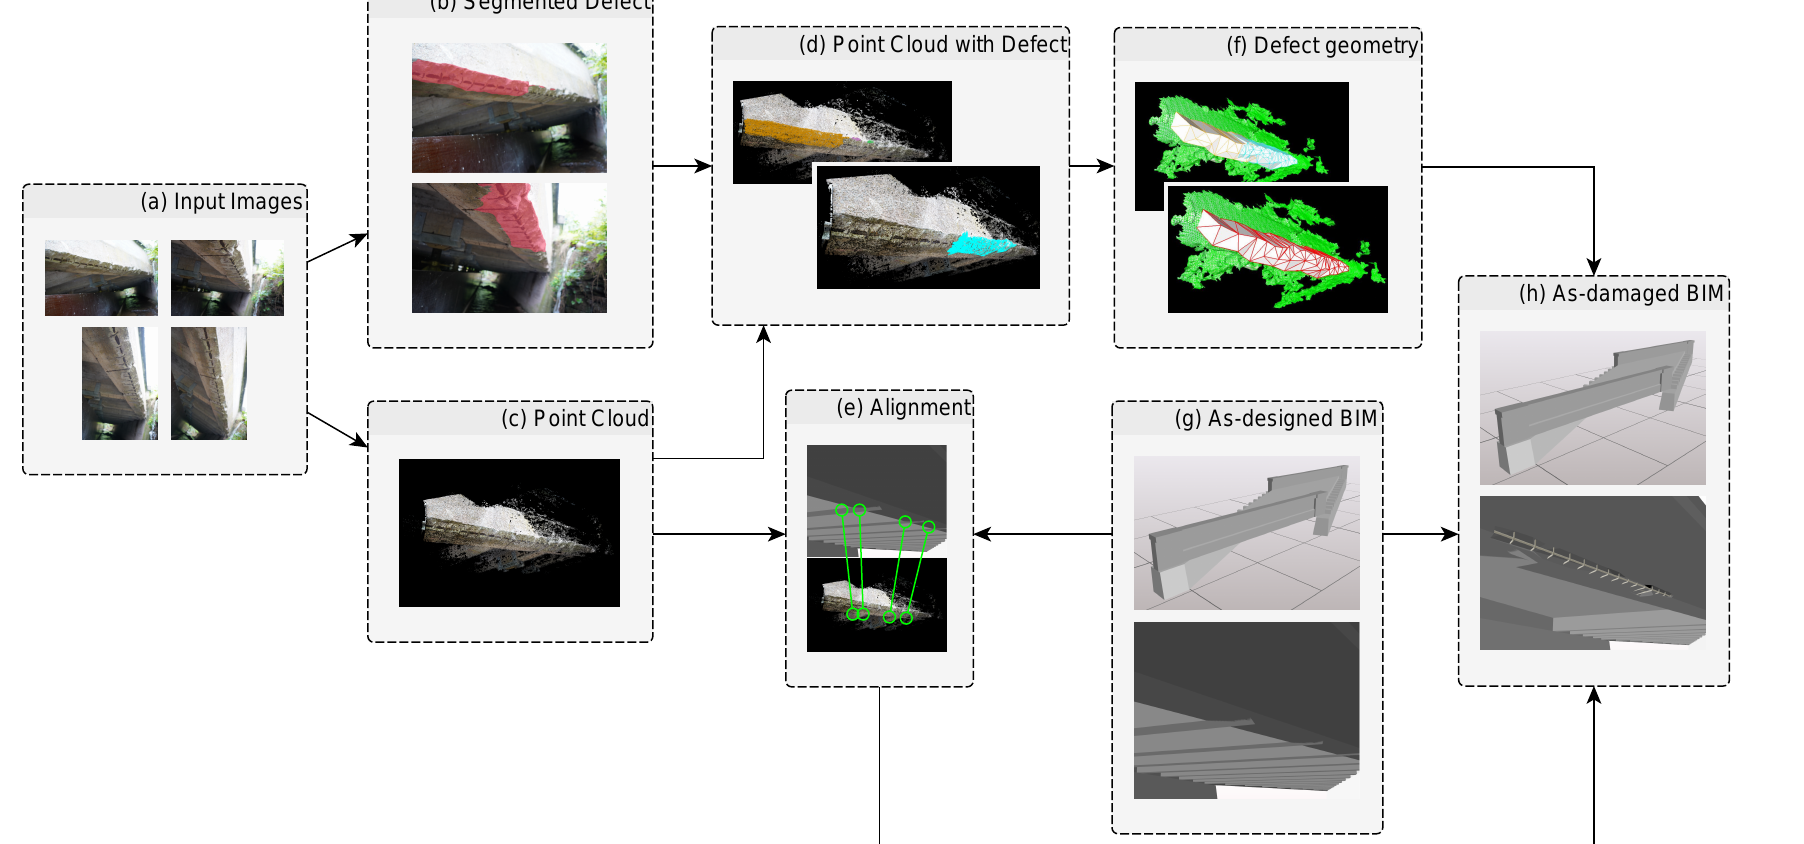
Figure 10. Overview of the case study with all included